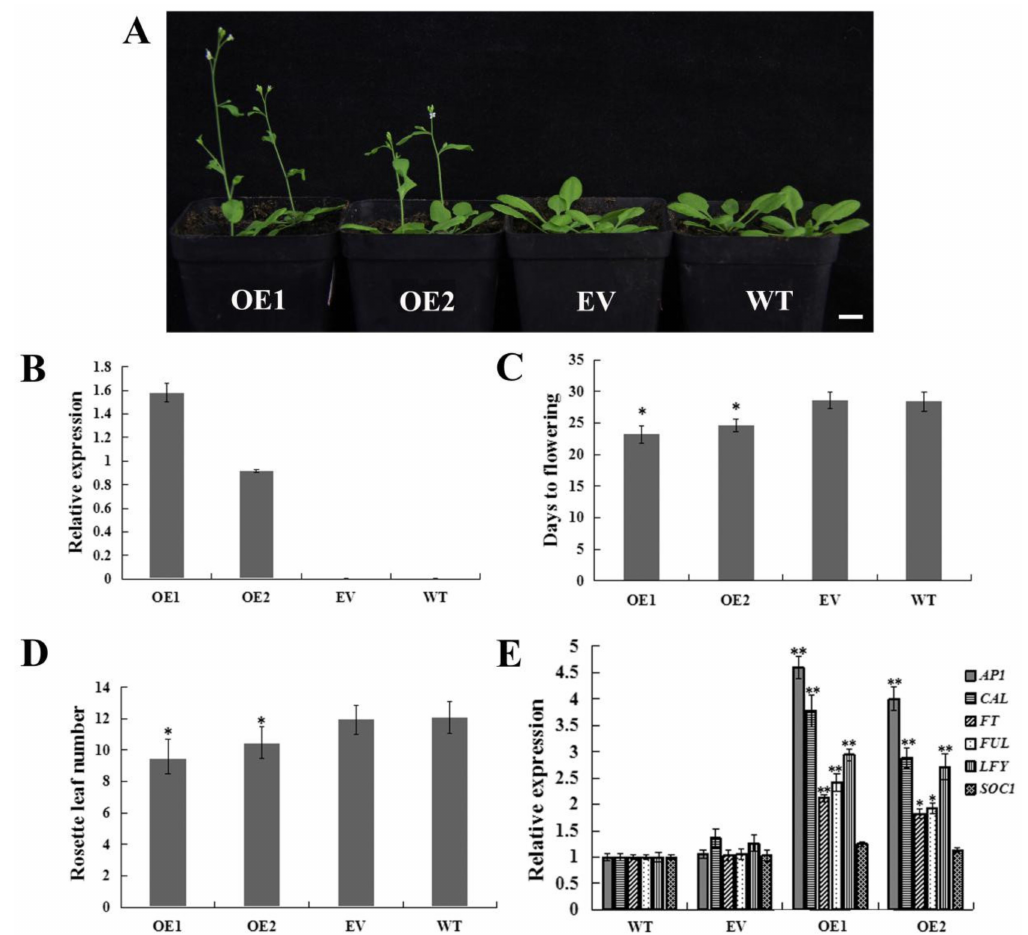
Figure 8. Flowering phenotype of CpWRKY71 OE plants. ( A ) The flowering phenotype of 24-day-old plants under LD condition. Bar denotes 1 cm. ( B ) Transcription levels analysis of CpWRKY71 in di ff erent lines. ( C ) and ( D ) The flowering time and rosette leaf number of plants grown under LD condition. Data represent the mean ± SD of 20 plants. ( E ) Expression levels of flowering-related genes in di ff erent lines. AtActin was used as an internal control. Data represent mean ± SD of three replicates. Error bars indicate standard deviation. Asterisks denote statistically significant di ff erences compared with control, * p < 0.05, ** p <